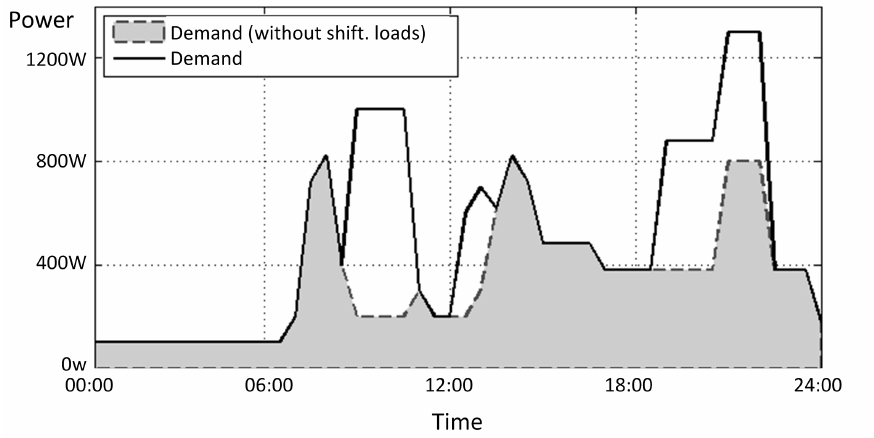
Figure 7. Representative demand curves from the stand-alone house